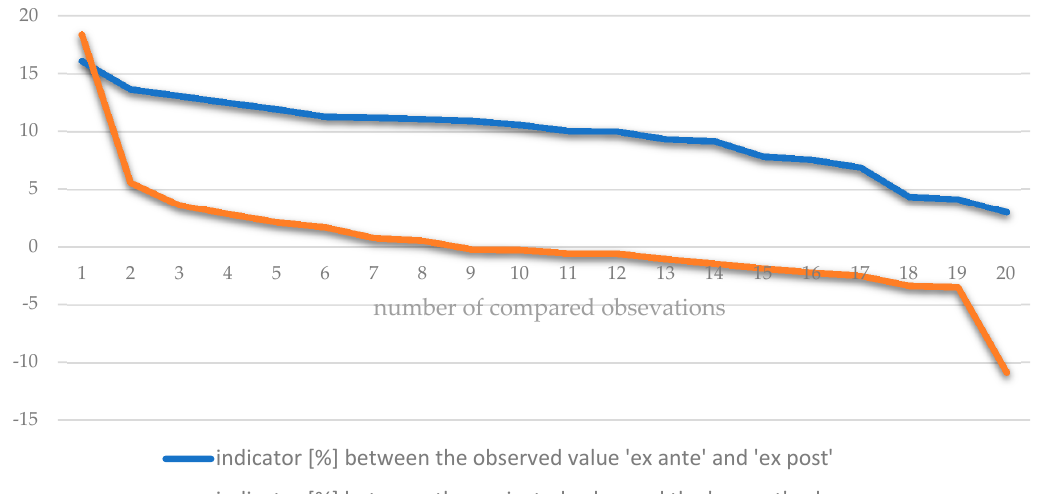
Figure 8. Ratios (%) between the value from the model and the observed “ex ante” value, as well as the forecast and observed values (%). Source: own study.